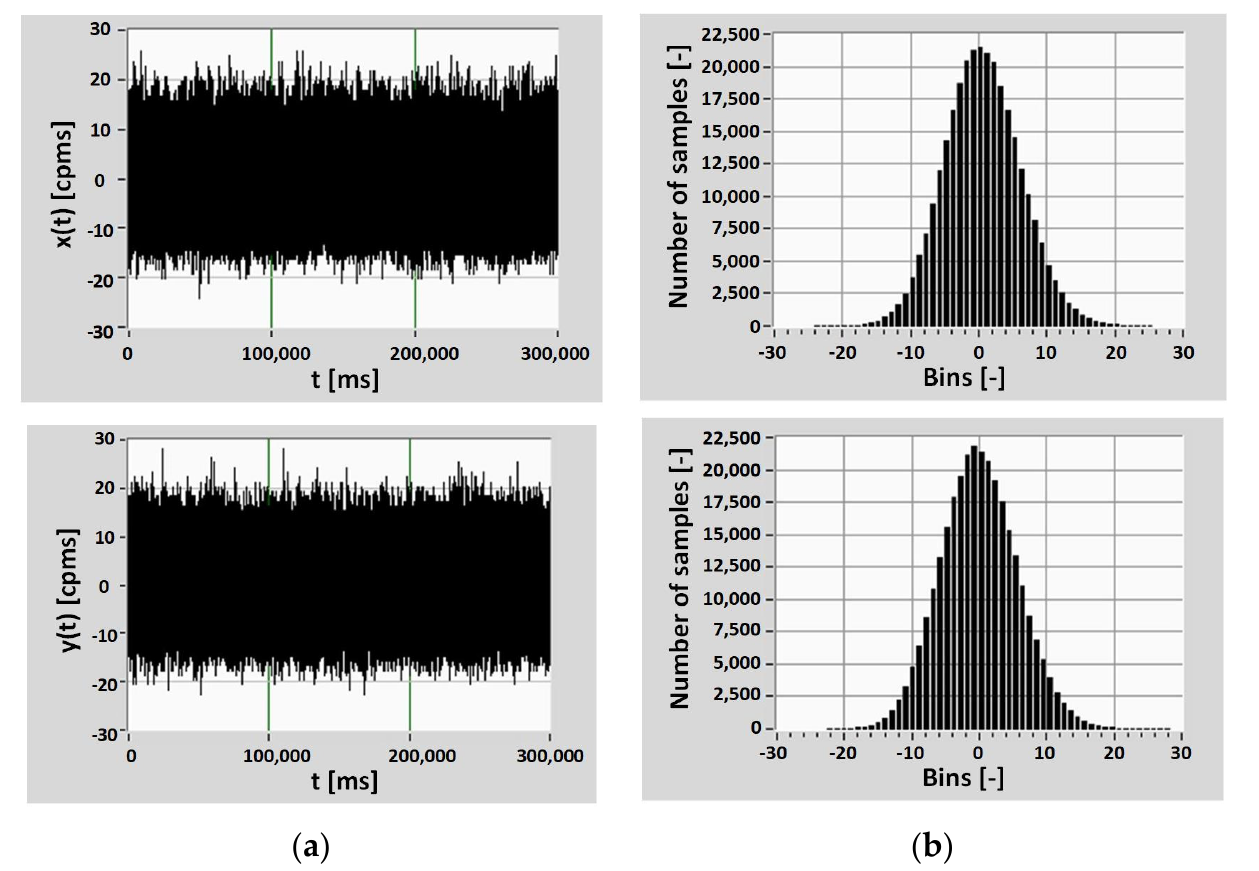
Figure 3. Recorded signals ( a ) and their histograms ( b ) obtained in the experiment BUB10.